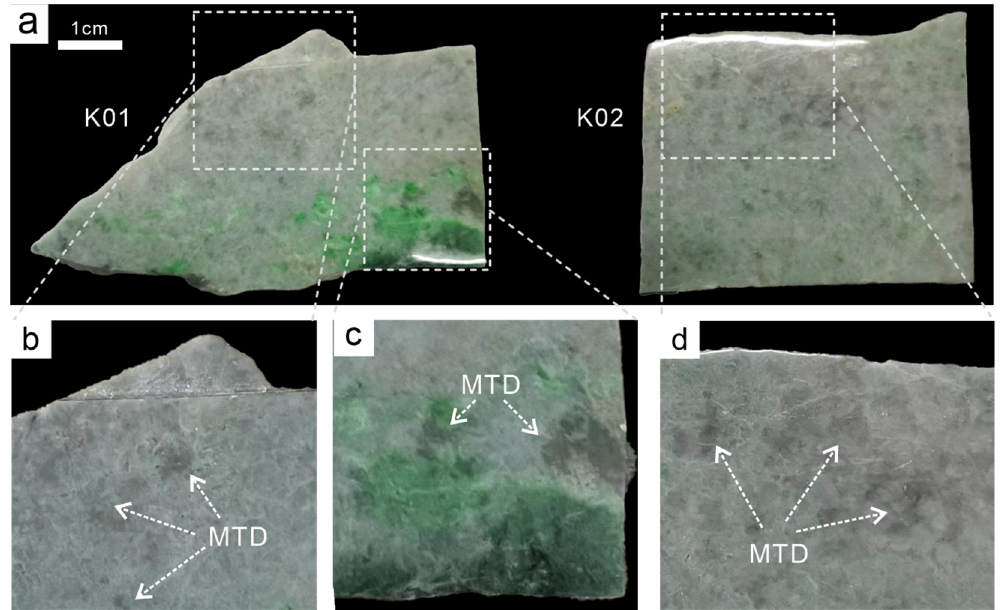
Figure 3. ( a ) Photos of the studied samples: smaller-grained, more transparent domains (MTDs) could be observed among the coarser-grained basement of the polished samples. ( b ‒ d ) Local mag- ni fi cation of several MTDs in ( a